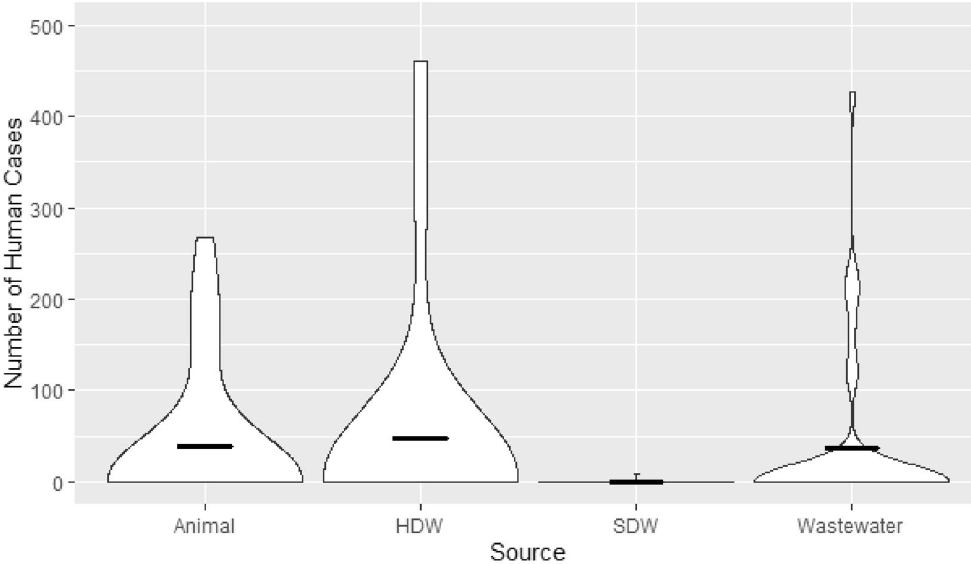
Figure 1. Violin Plot of the proportion of Human Cases Attributable to Each Environmental Source. The bold horizontal line for each source represents the mean for each source. The bold horizontal line for each source represents the mean for each source. HDW Household Drinking Water, SDW Source Drinking